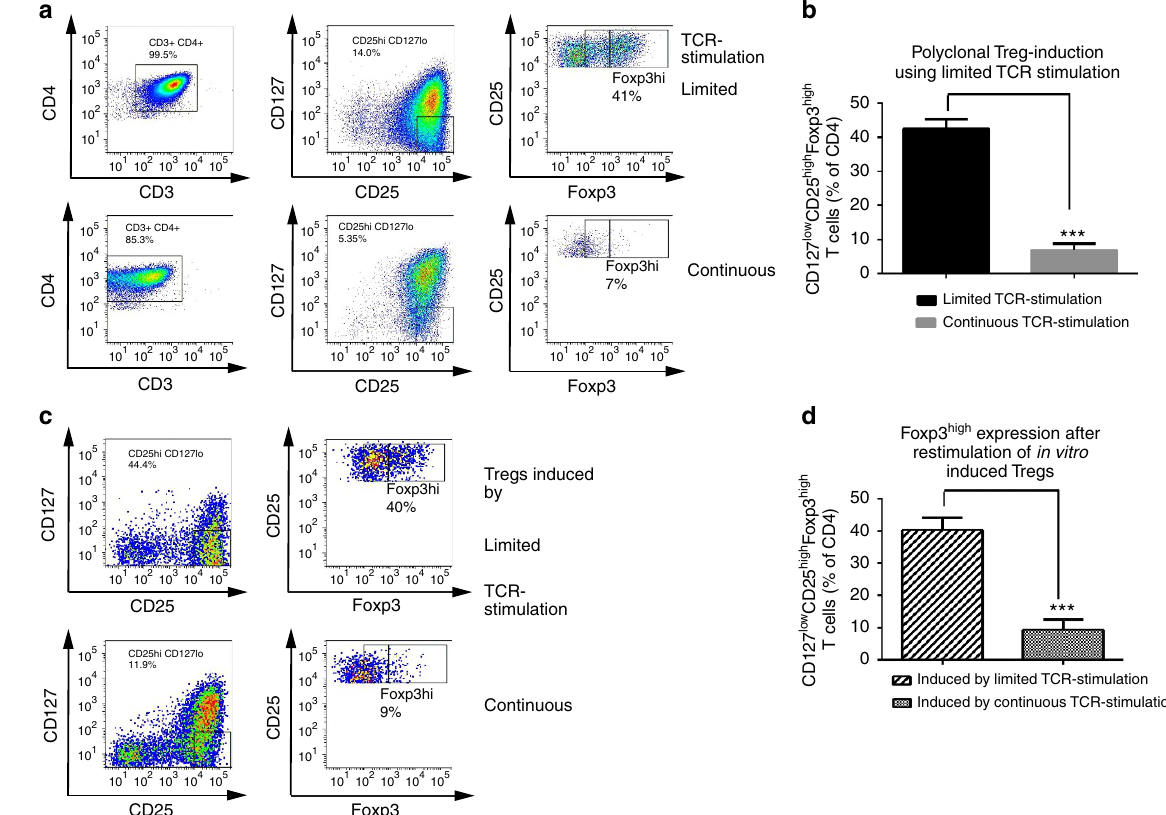
Figure 6 | Stability of human Foxp3 þ Tregs induced by sub-immunogenic TCR stimulation in vitro . ( a ) Polyclonal induction of Tregs by limited TCR stimulation in vitro . Representative FACS plots of limited (12h) and continuous (54h) TCR stimulation. ( b ) Frequency of Foxp3 high Tregs induced by limited or continuous TCR stimulation. Data are presented as the mean ± s.e.m. ( n ¼ 5) of duplicate wells in five individual experiments. *** P o 0.001 (Student´s t -test). ( c ) Stability of Tregs induced by limited or continuous TCR stimulation in vitro . Representative FACS plots prepared after re-stimulation of CD127 low CD25 high Tregs that had been previously induced by continuous or limited polyclonal TCR stimulation to assess Treg stability. ( d ) Frequency of induced Tregs following re-stimulation. Data are presented as the mean ± s.e.m. ( n ¼ 5) of duplicate wells in five individual experiments. *** P o 0.001 (Student´s t